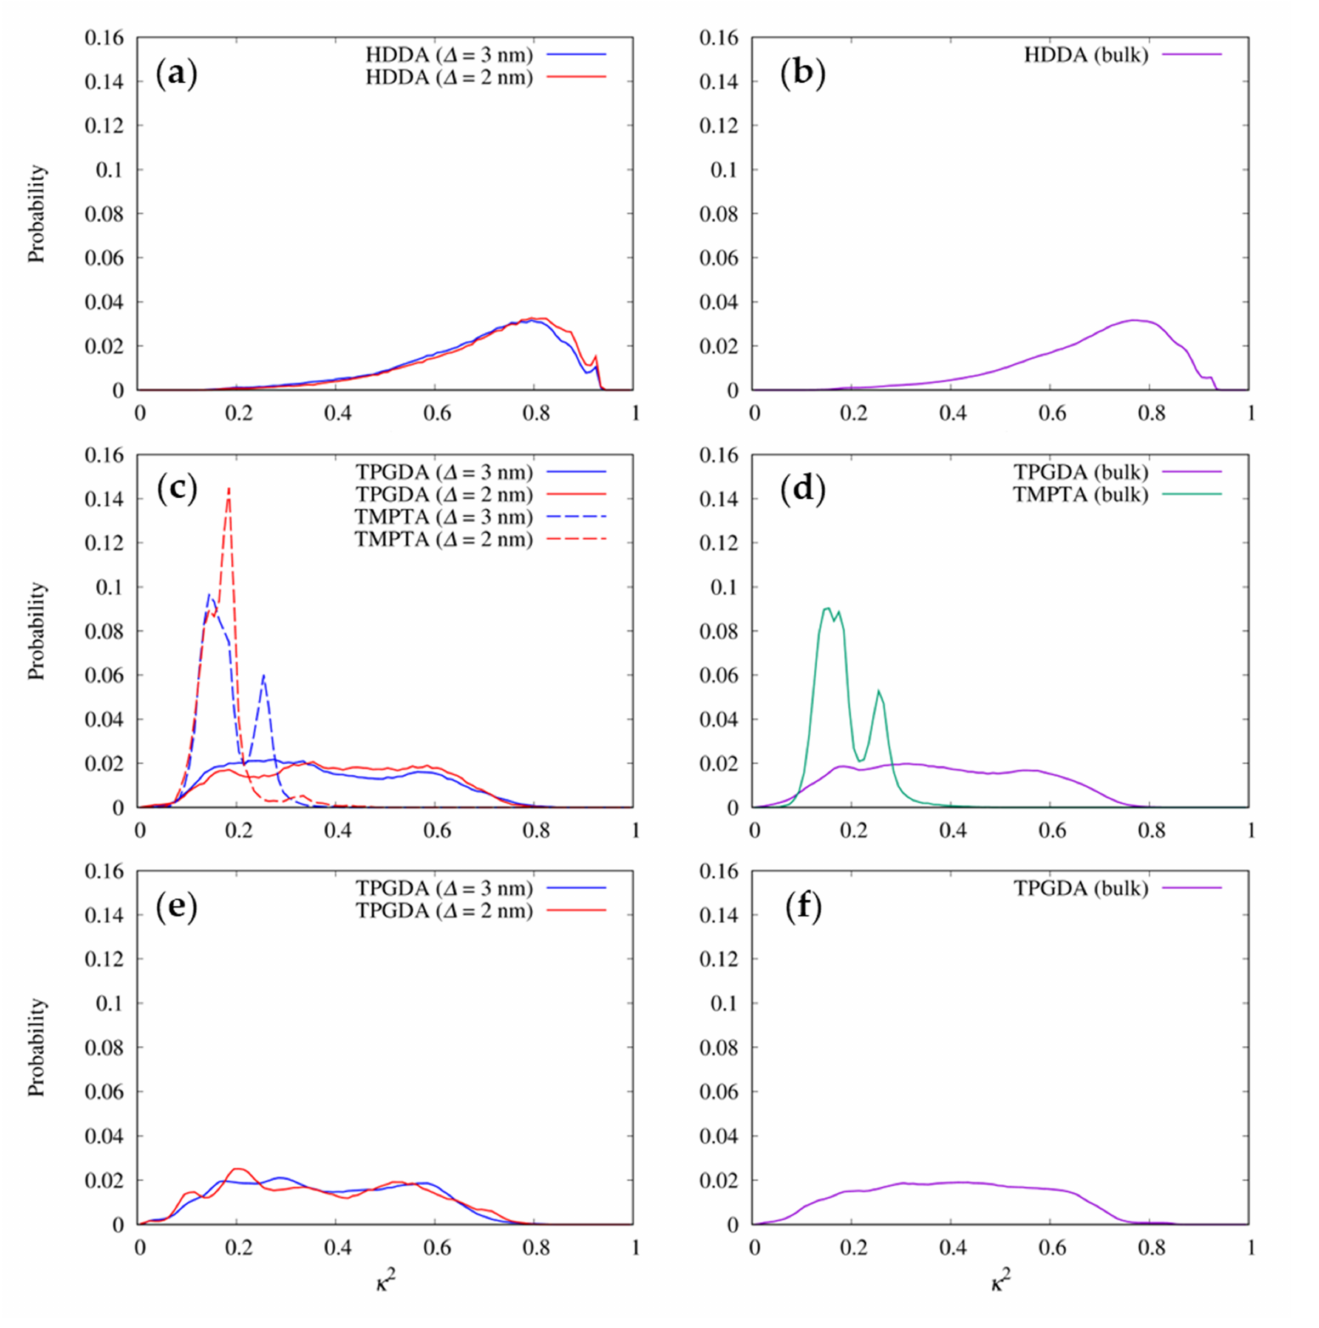
Figure 4. Distributions of the relative shape anisotropy, κ 2 , of the multi-functional resist molecules: HDDA of resist I in ( a ) the trenches and ( b ) bulk state; TPGDA and TMPTA of resist II in ( c ) the trenches and ( d ) bulk state; and TPGDA of resist IV in ( e ) the trenches and ( f ) bulk